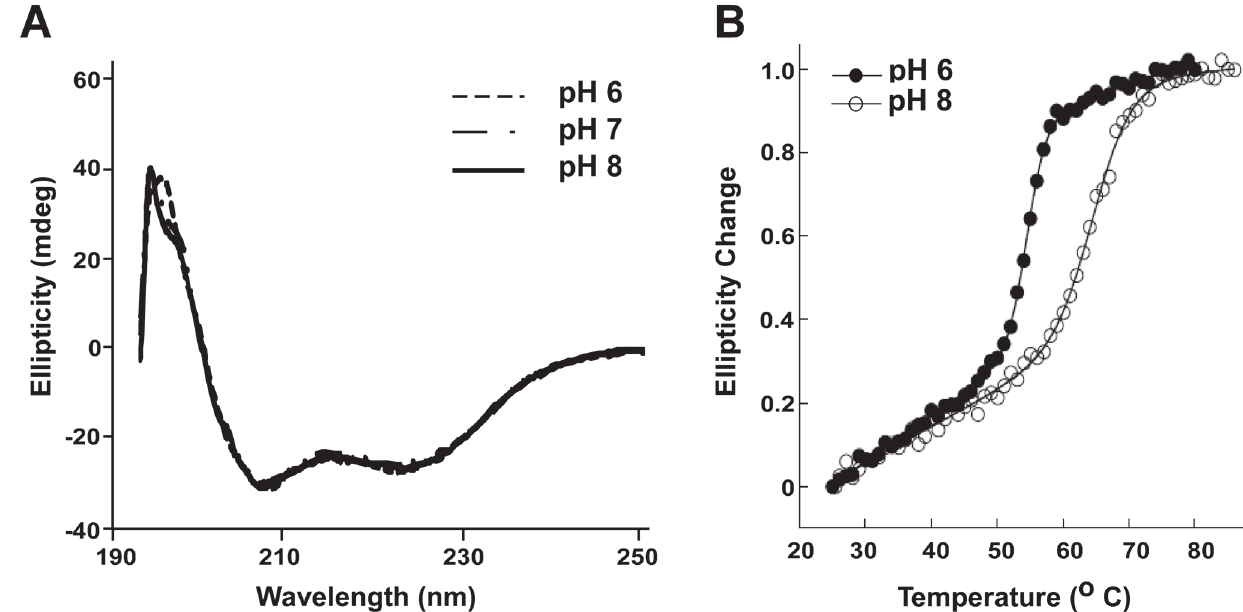
Fig 4. Effect of pH on DksA global structure and stability. (A) CD spectra recorded at room temperature using 50 μ M DksA in phosphate buffer at different pHs. (B) Normalized ellipticity at 220 nm during a 1 degree/minute increase in temperature. Data were fit to the modified Gibbs-Helmholtz equation with linear temperature dependence before and after the transition region. Melting temperatures were 55 and 65°C at pH 6 and 8, respectively.